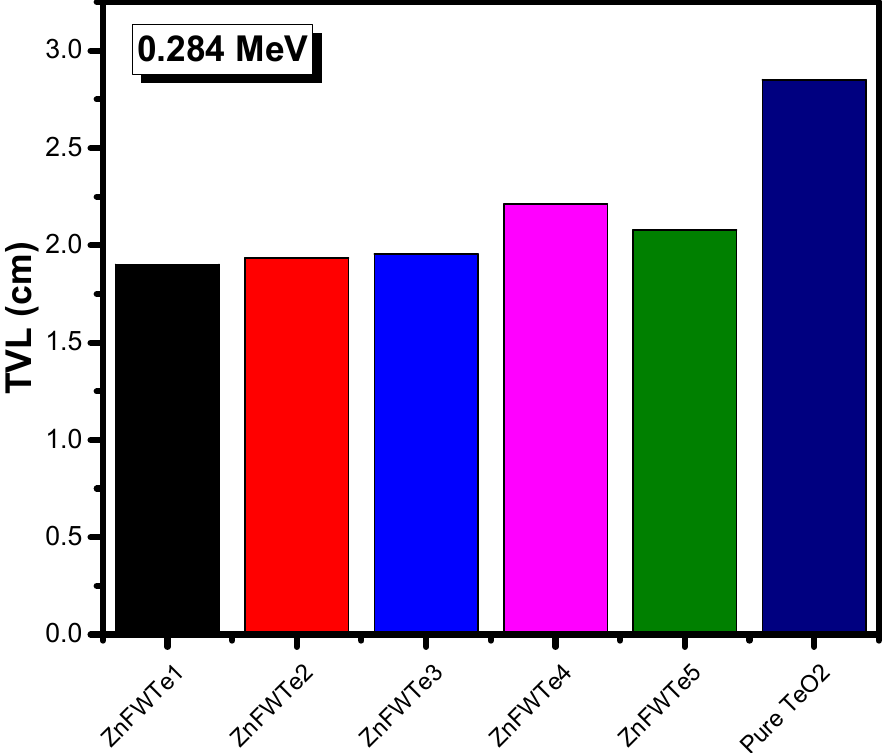
Figure 5. The tenth value layer for the selected oxyfluoride tellurite glasses at 0.284 MeV.